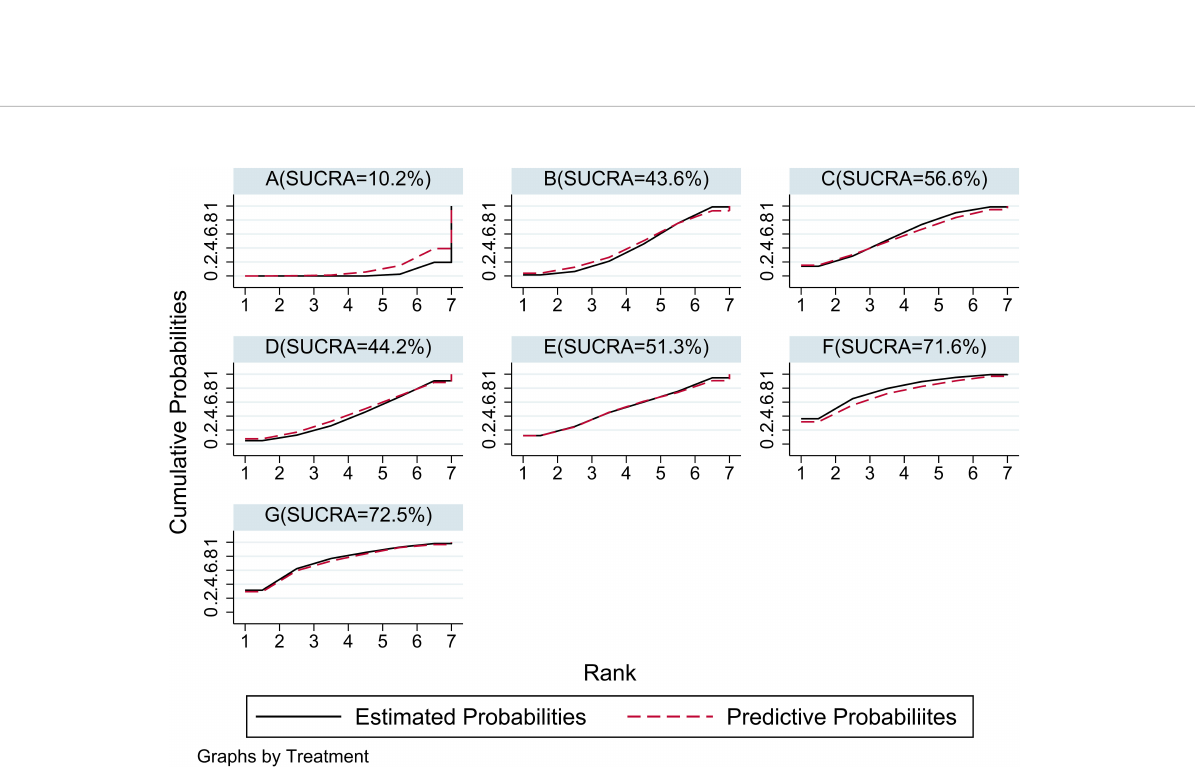
FIGURE 7 SUCRA rank plot of seven interventions. If the SUCRA approaches 100%, the intervention is the best among the included trials; conversely, if it is close to 0%, it represents the worst intervention. (A) placebo; (B) TNF- a Etanercept; (C) IL-17A Secukinumab LD; (D) IL-17A Secukinumab HD; (E) IL-17A Ixekizumab; (F) IL-23 Ustekinumab LD; (G) IL-23 Ustekinumab